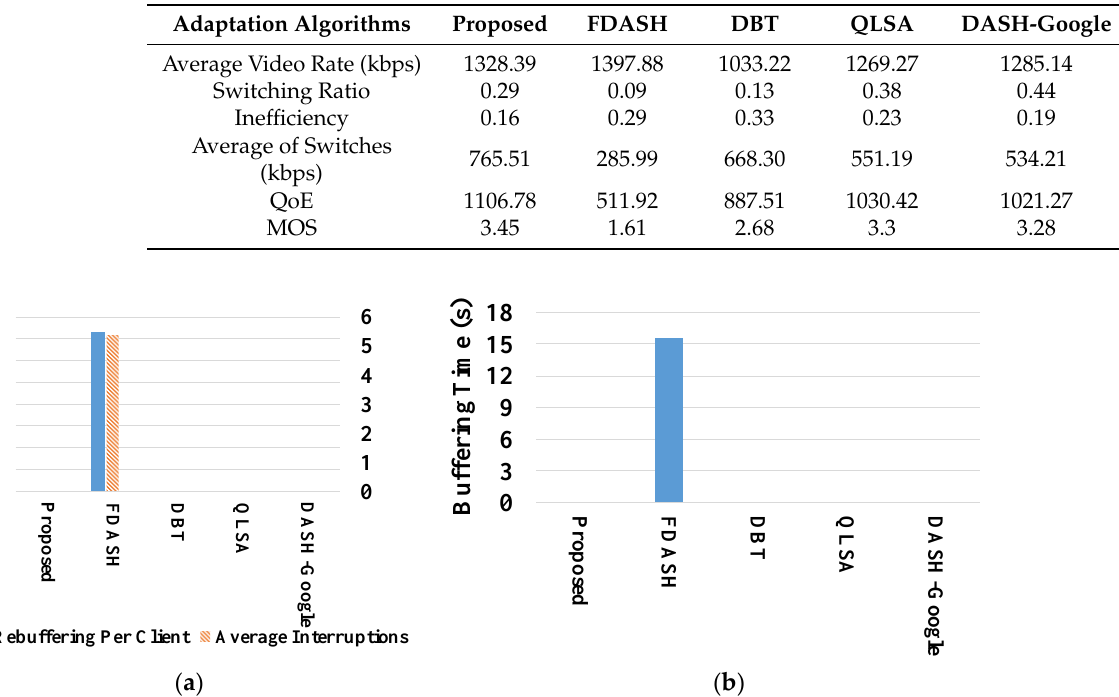
Figure 8. Comparison of ( a ) rebufferings per client and average number of interruptions, and ( b ) average buffering time when the clients downloaded Dataset 1. The buffer size and segment duration were set to 30 s and 4 s, respectively.